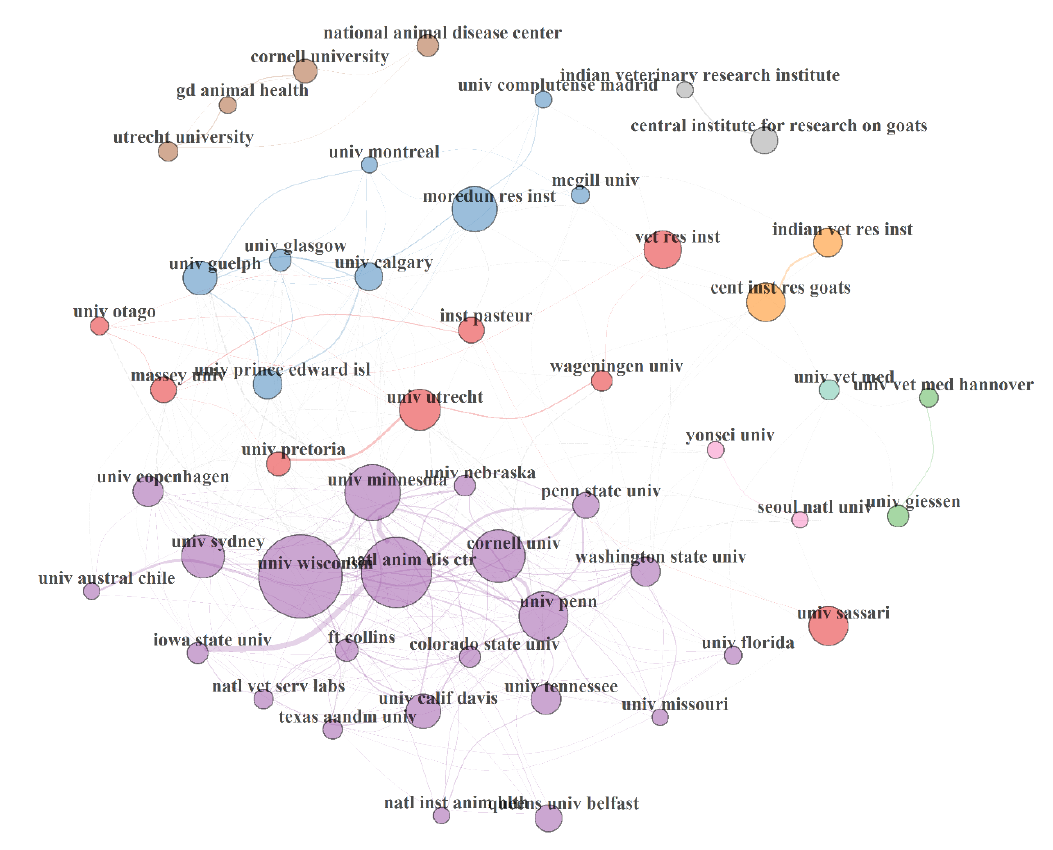
Figure 6. Institution collaboration network (ICN) in MAP research from 1911 to 2019. The top 50 institutions were displayed. The collaborative network performance statistics are as listed: size = 2124, density = 0.002, transitivity = 0.235; diameter = 15; degree of centralization = 0.049; average path length = 5.408, closeness of centralization = 0.001, betweenness of centralization = 0.088, eigenvector of centralization = 0.98 and networkDegreeDist = 279. The circle volume of each institution correspond to its sharing strength/publication count, connecting curve/line between two institutions indicated bidirectional relationship between the institutions; the thickness of the curve/line revealed strength of the bidirectional collaborative relationships; institutions with the same colour belong to the same cluster of collaborative institution community; isolated institution(s) is/are deficient in collaboration.